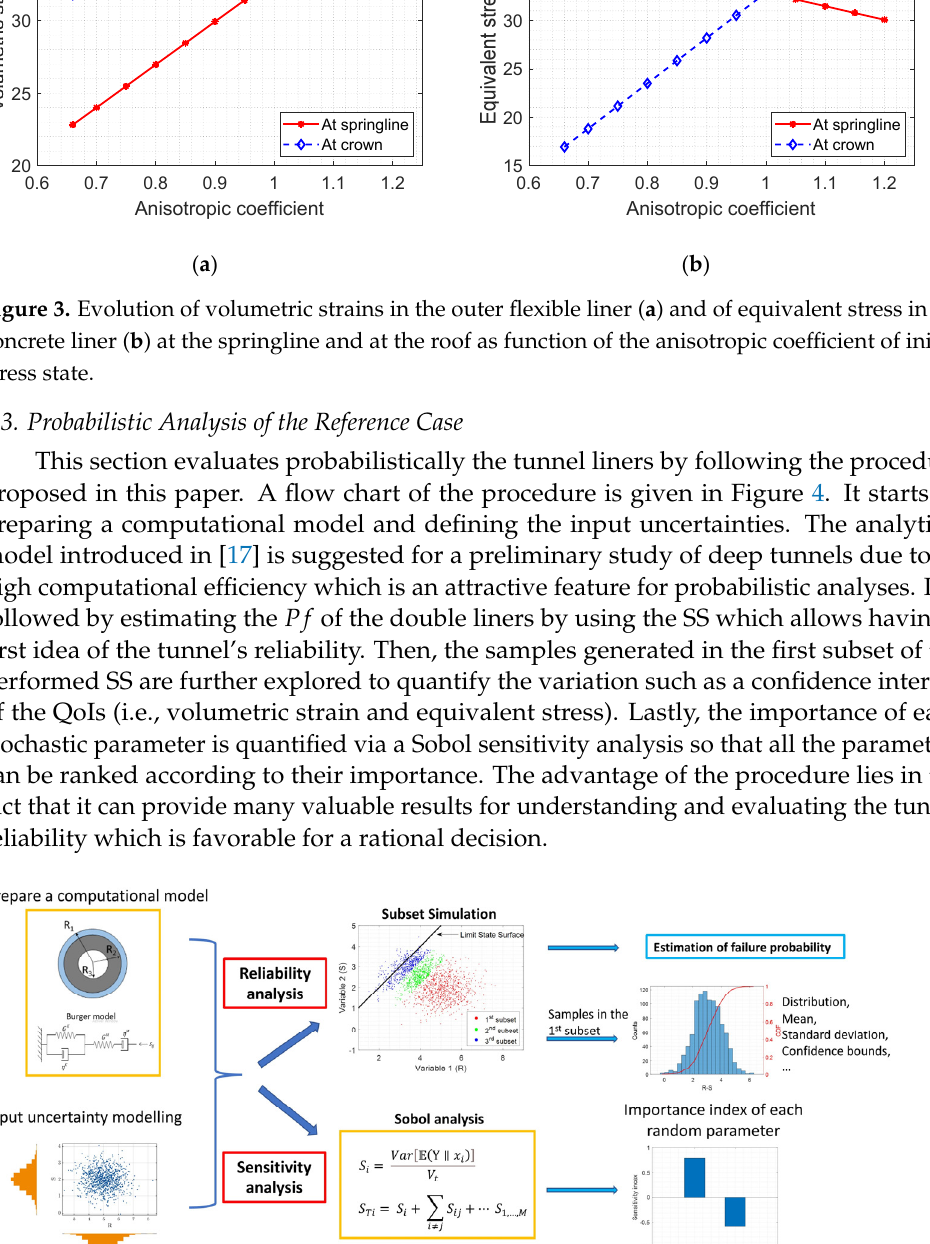
( b ) Figure 2. Distribution of volumetric strains at the intrados of the outer flexible liner ( a ) volumetric strain and of equivalent stress at the intrados of the concrete liner ( b ) equivalent stress. An investigation with different values of anisotropic ratio in the range 𝜆 ∈ (cid:4670)0.66, 1.2(cid:4671) as depicted in Figure 3 is then performed. Only the results at the springline and crown are